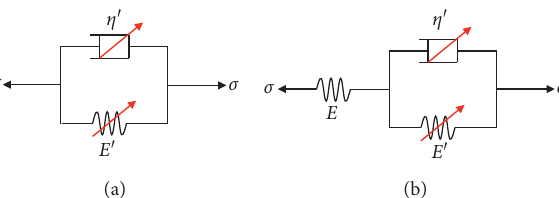
Figure 16: Schematic diagram of the creep damage constitutive model based on fractional derivatives theory and damage mechanics theory: (a) improved Kelvin model; (b) three-element creep damage constitutive